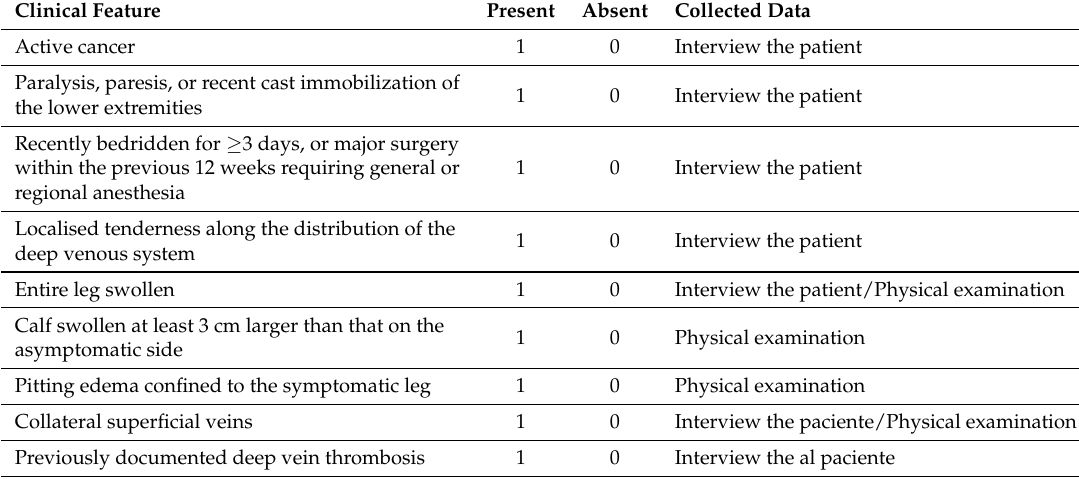
Table 4. Assignment by risk